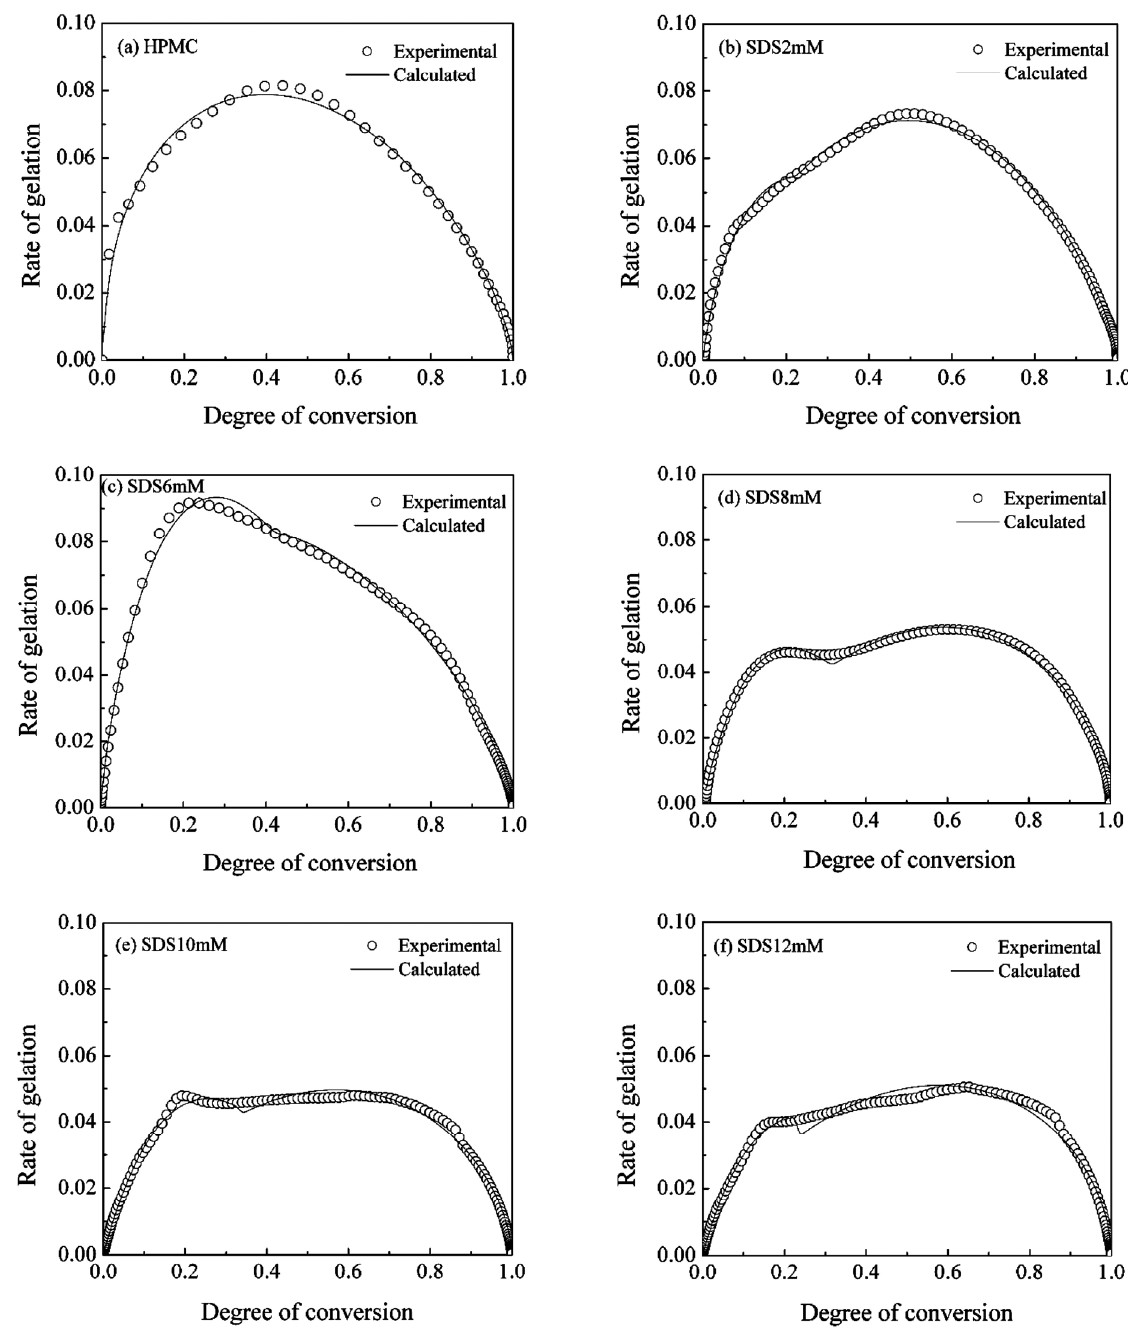
Figure 10. Effect of SDS on gelation kinetics for 1.0 wt% HPMC